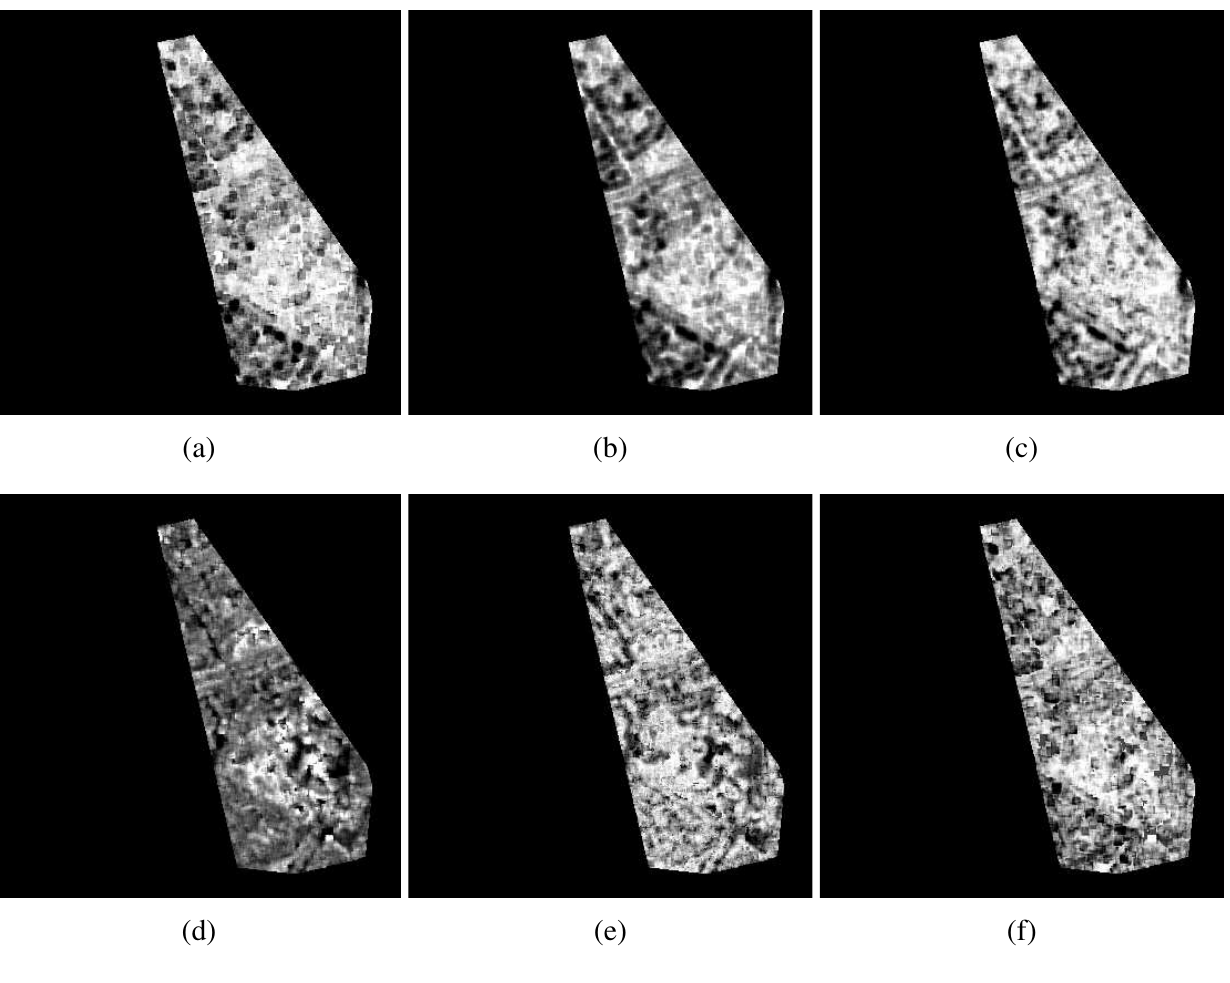
Similarity images of the push-broom and SAR data - case a : (a) distance to independence; (b) mutual information; (c) cluster reward algorithm; (d) Woods criterion; (e) robust Woods criterion; (f) correlation